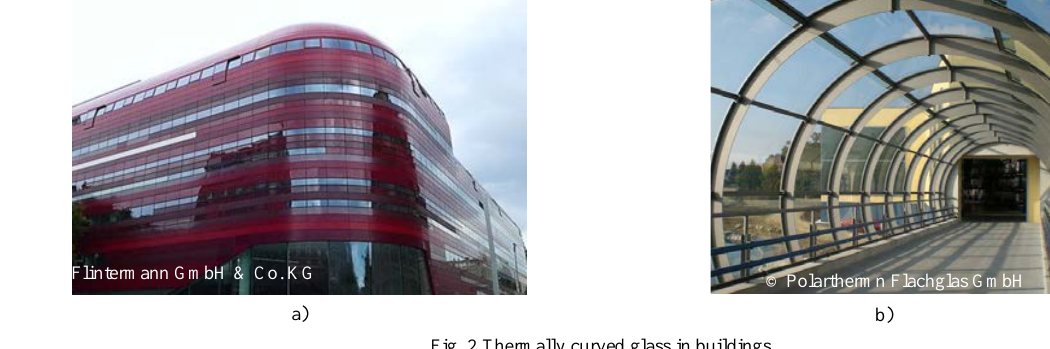
Fig. 2 Thermally curved glass in